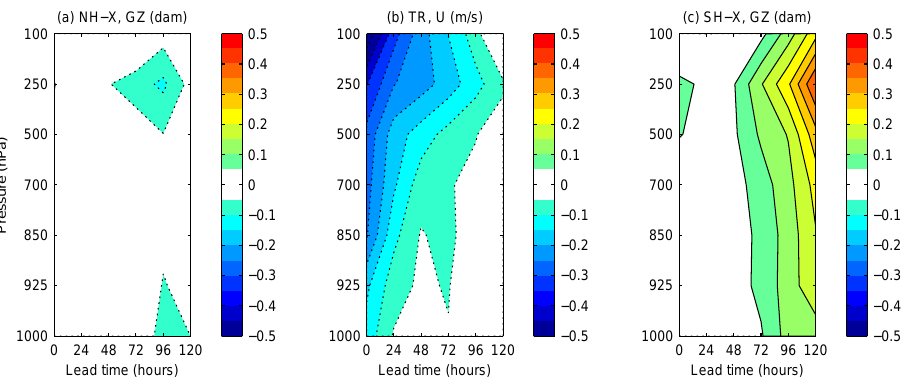
Fig. 7. Same as Fig. 5, except showing the difference in standard deviation relative the ERA-Interim reanalyses for the EnVar and 4D-Var experiments for the February/March 2011 period. Note that negative values correspond with improved forecasts from EnVar analyses as compared with forecasts from 4D-Var